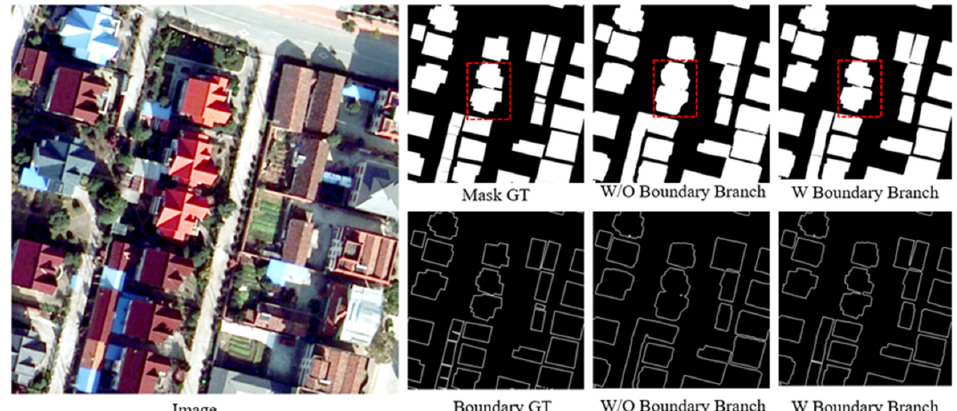
Figure 19. Boundary branch ablation experiment. The left side is the image, the upper part of the right side represents the results of semantic segmentation in the ablation experiment, and the lower part of the right side represents the results of boundary in the ablation experiment.